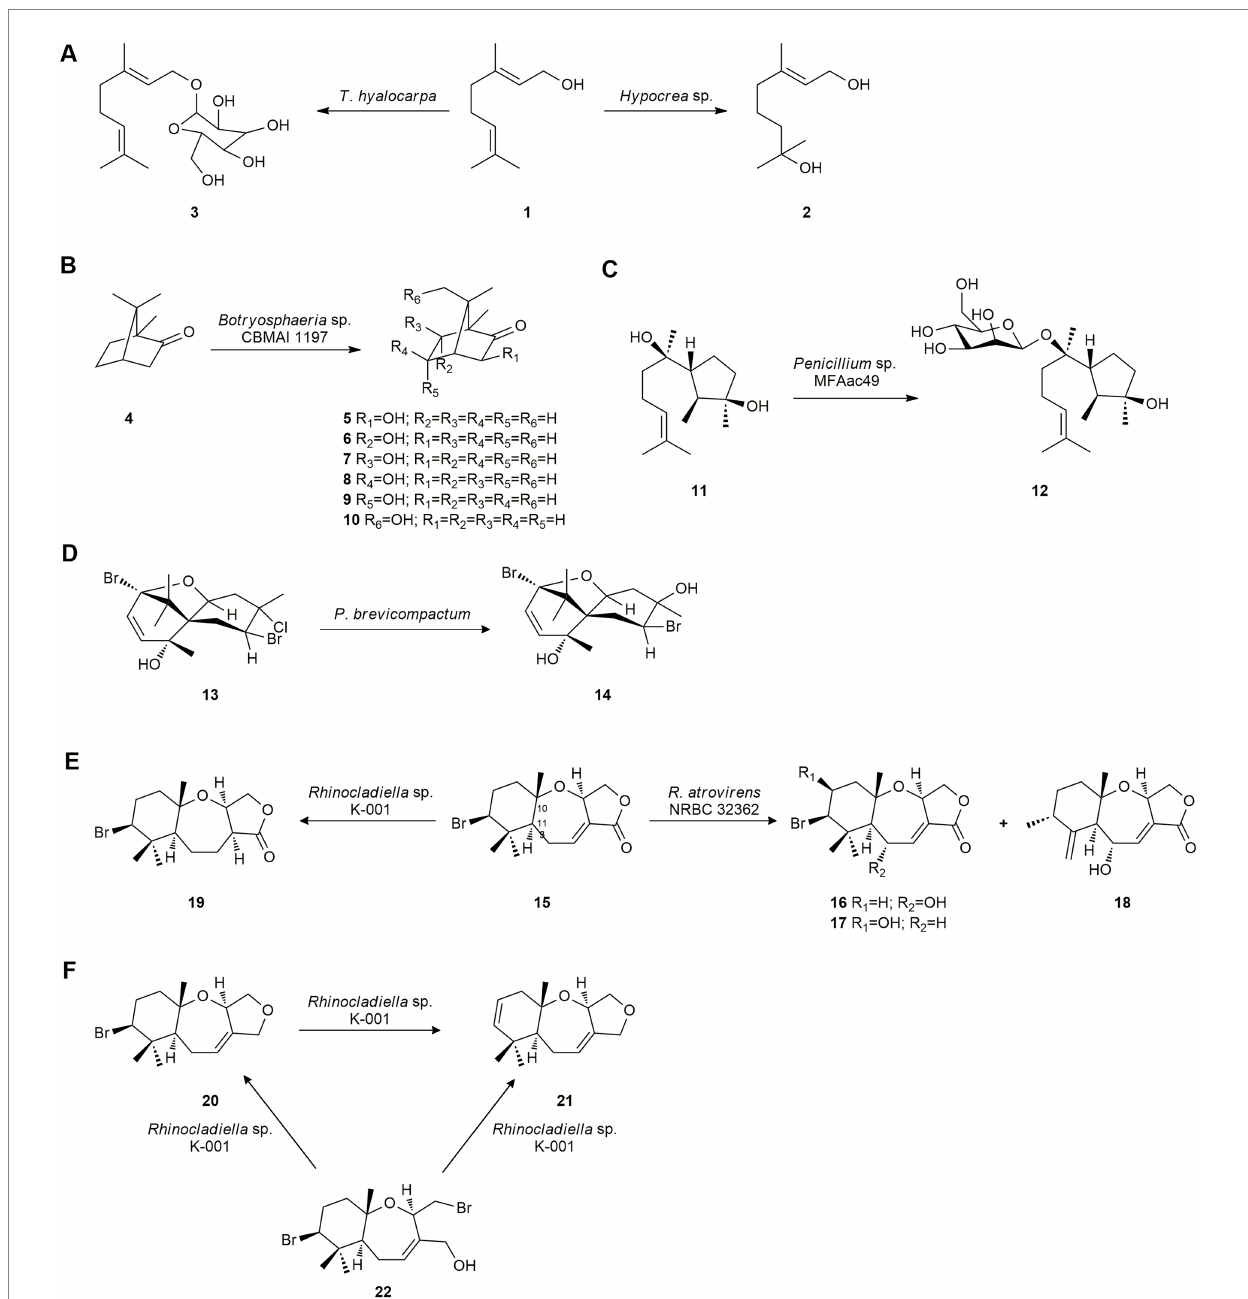
FIGURE 1 Terpene biotransformations. (A) Geraniol ( 1 ) biotransformation by Thielavia hyalocarpa and Hypocrea sp. (Yun et al., 2015). (B) Camphor ( 4 ) biotransformation by Botryosphaeria sp. (de Jesus et al., 2017). (C) Cyclonerodiol ( 11 ) mannosidation by the marine-derived fungus Penicillium sp. MFAac49 (Li et al., 2007). (D) Pacifenol ( 13 ) bioconversion by Penicillium brevicompactum (San-Martín et al., 2008). (E) Biotransformation of aplysistatin ( 15 ) by Rhinocladiella sp. K-001 and Rhinocladiella atrovirens NRBC 32362. (F) Biotransformation of hydroxypalisadin B ( 22 ) and palisadin A ( 20 ) by Rhinocladiella sp. K-001 (Koshimura et al.,